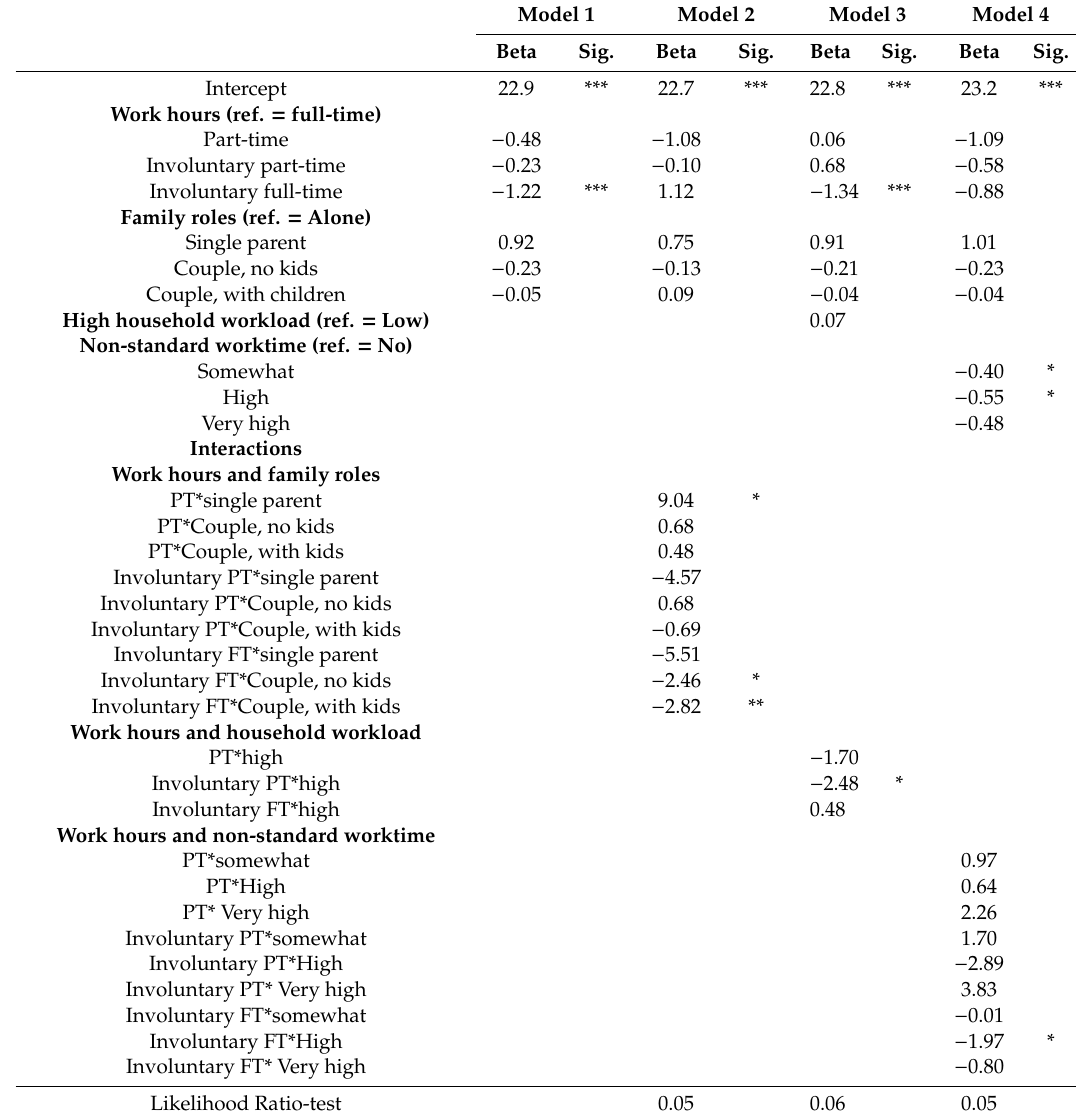
Table 3. Random e ff ect models for di ff erence in MCS scores in 10,266 observations for men (population in salaried employment, 20–60 years old, GSOEP wave 21–27. Models controlled for baseline MCS, year, age, income, occupational class, and physical